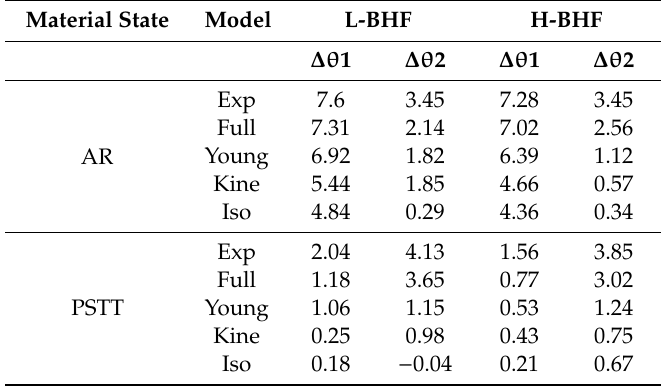
Table 10. Summary of the springback angles after forming for each model and